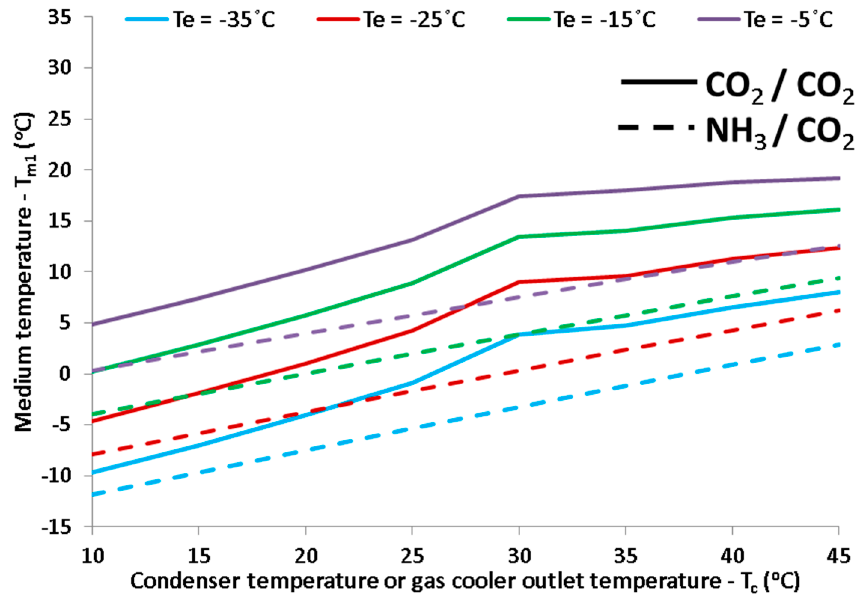
Figure 5. Optimum medium temperature ( T m 1 ) at different operating conditions for CO 2 /CO 2 and CO 2 /NH 3 systems.